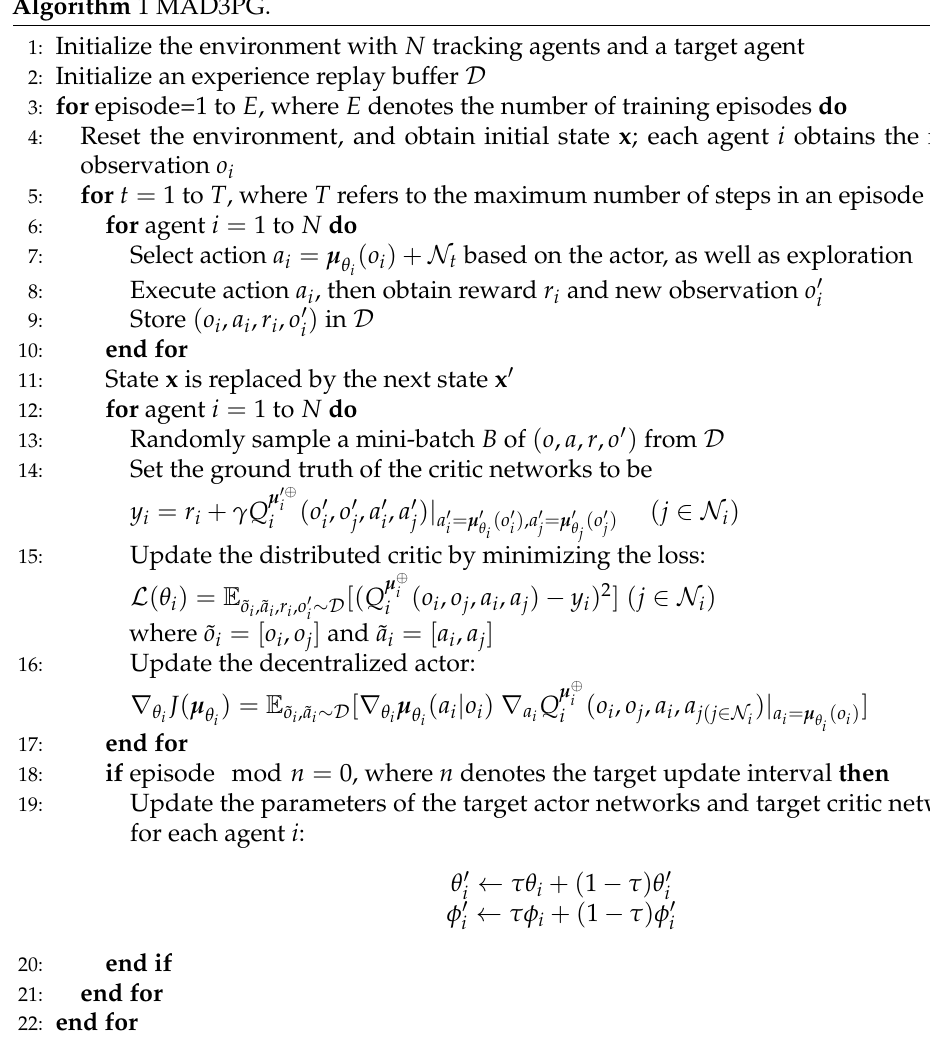
Figure 2. Frameworks of the MAD3PG. Algorithm 1